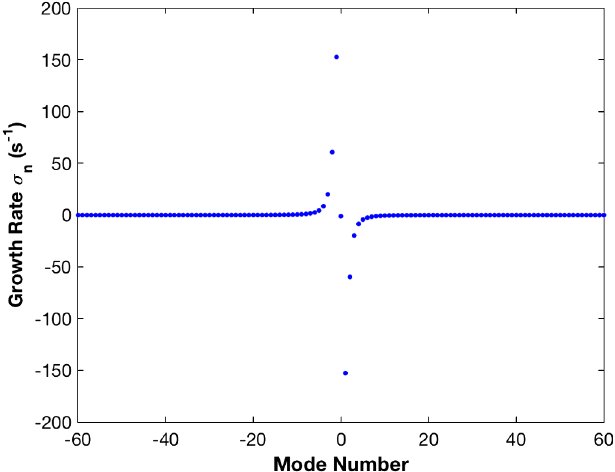
FIG. 9. Growth rates with mode number. Rf feedback off. Q ¼ 20000 , Detuning Δ f ¼ − 10 . 4 L